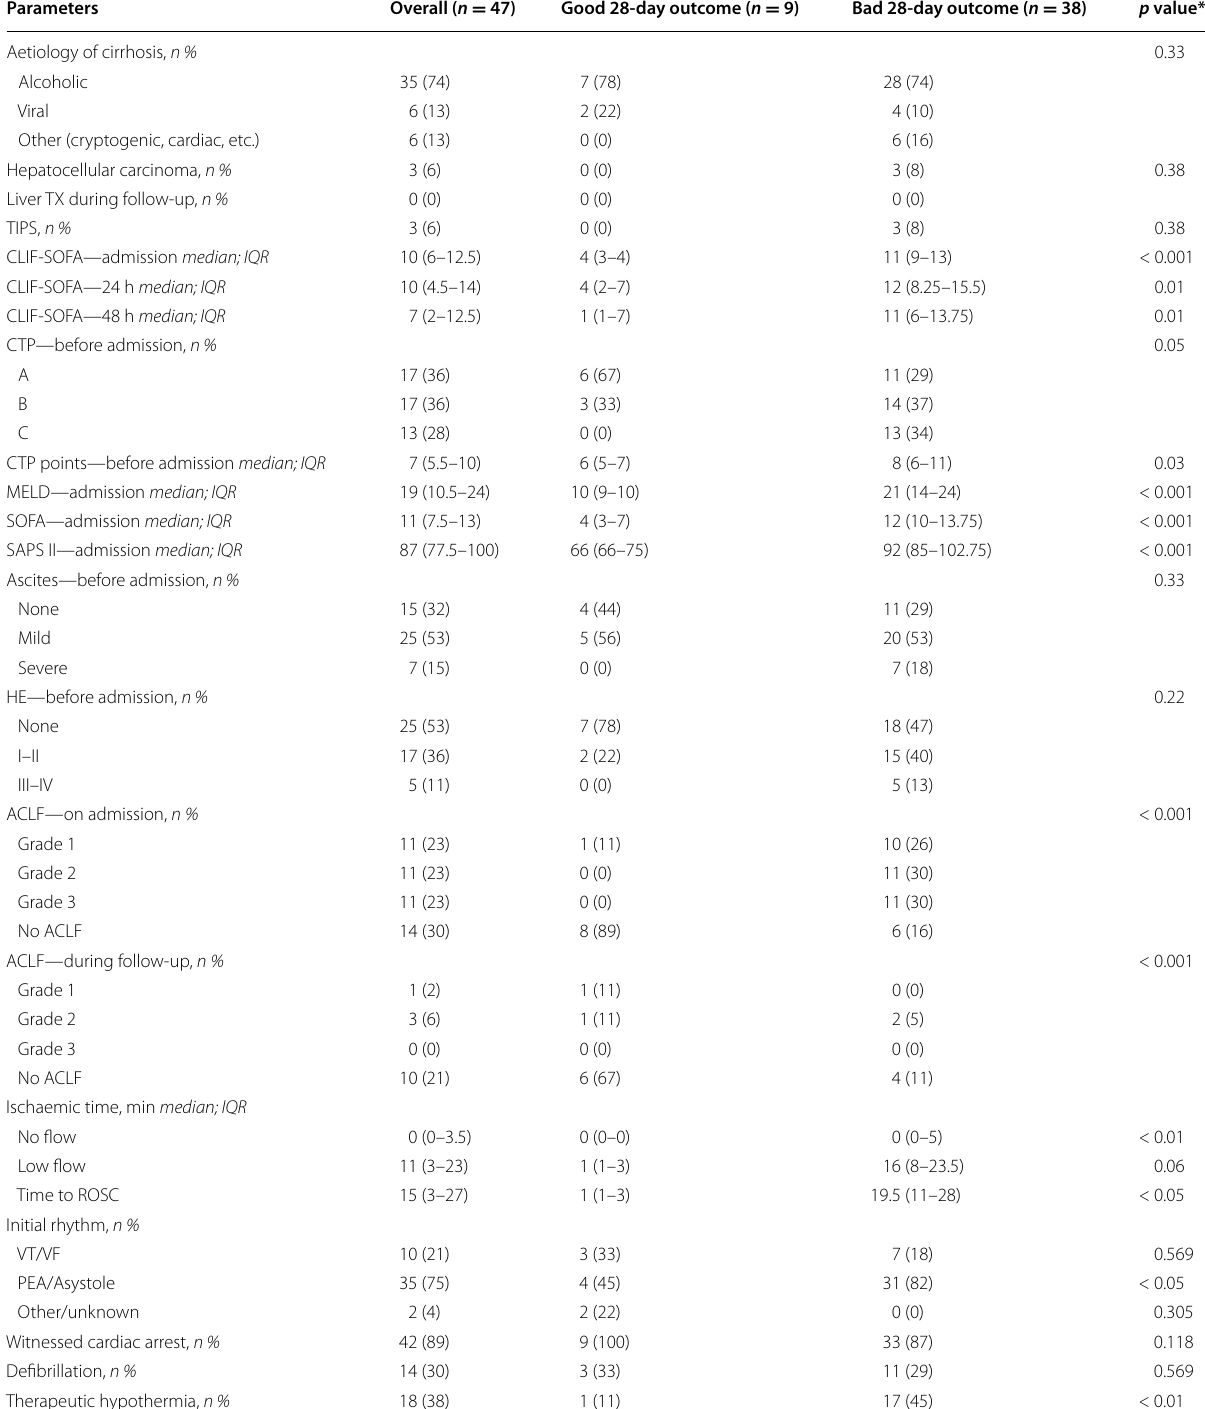
Table 2 Characteristics of patients with cirrhosis stratified according to good 28-day outcome and bad 28-day outcome Parameters Overall ( n